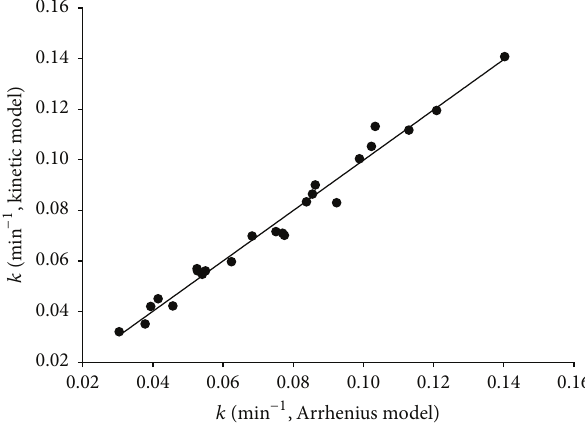
Figure 4: Ratio between the 𝑘 values obtained by the kinetic model and by the Arrhenius model.